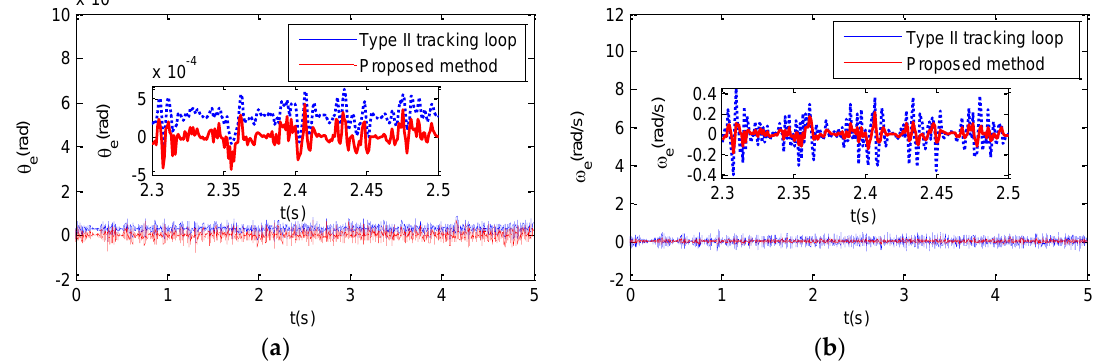
Figure 10. Estimation errors of the two demodulation methods in Case 2. ( a ) Rotor position estimation error; ( b ) rotor velocity estimation error.